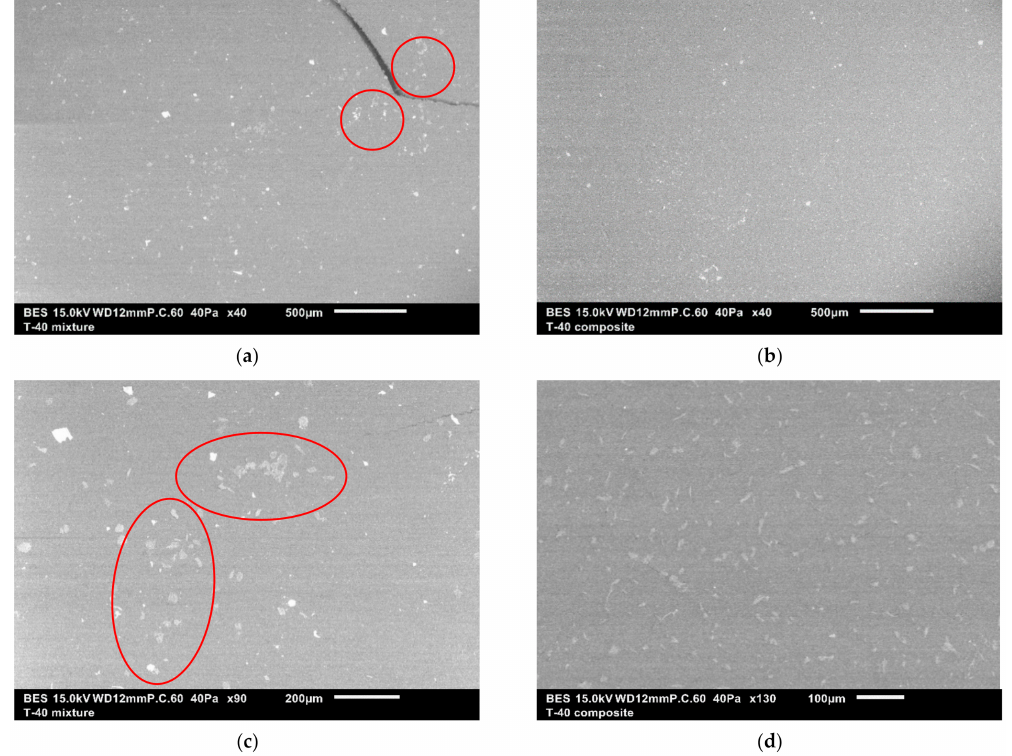
Figure 10. Surface morphology of a T-40 mixture (( a , c ), magnification 40 × ; and 90 × ; respectively) and T-40-m composite specimen (( b , d ), magnification 40 × ; and 90 × , respectively). Working distance 25 mm, OA 1, AV 10 kV, P.C.